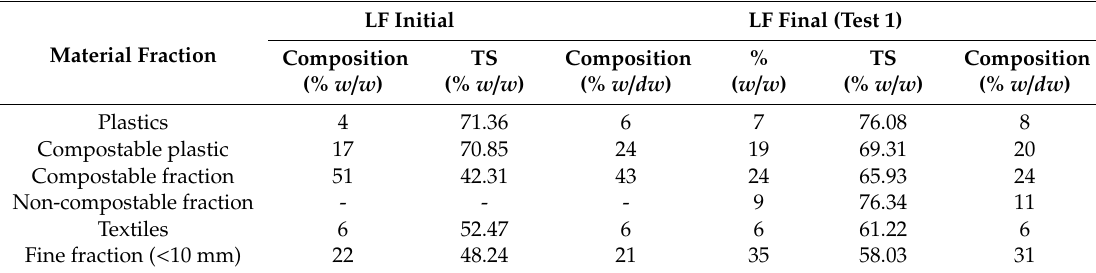
Table 2. Material composition